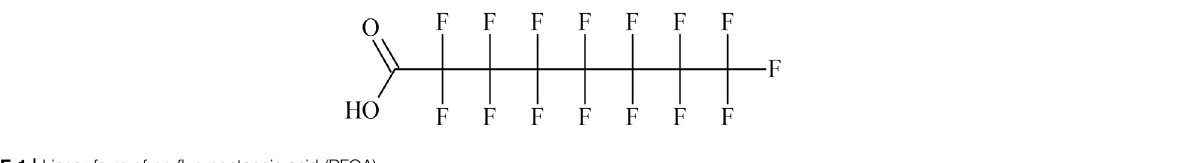
FIGURE 1 | Linear form of per fl uorooctanoic acid